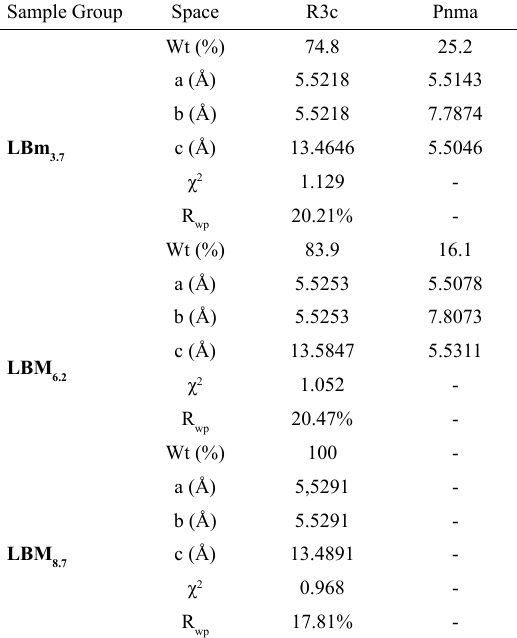
and goodness of fit χ 2 wt , LBM and LBM 3.7 6.2 8.7